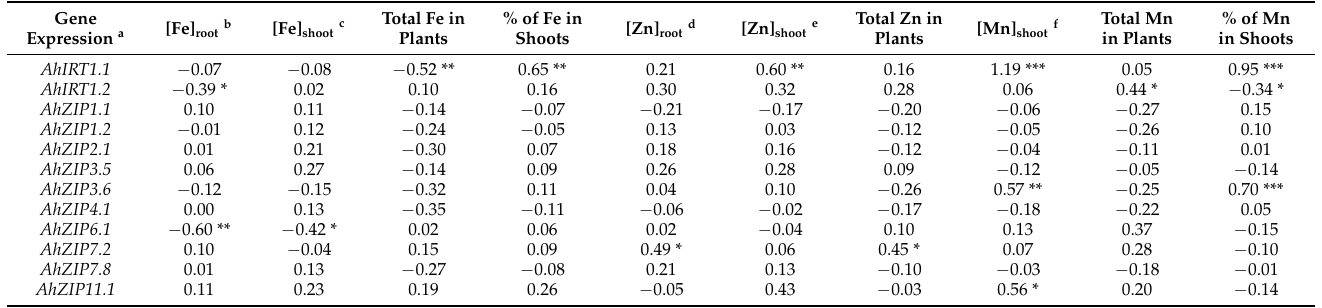
Table 3. Stepwise linear regression analysis ( β value) of metal accumulation and the expression of AhZIP genes in the roots of Fenghua 1 and Silihong ( n =